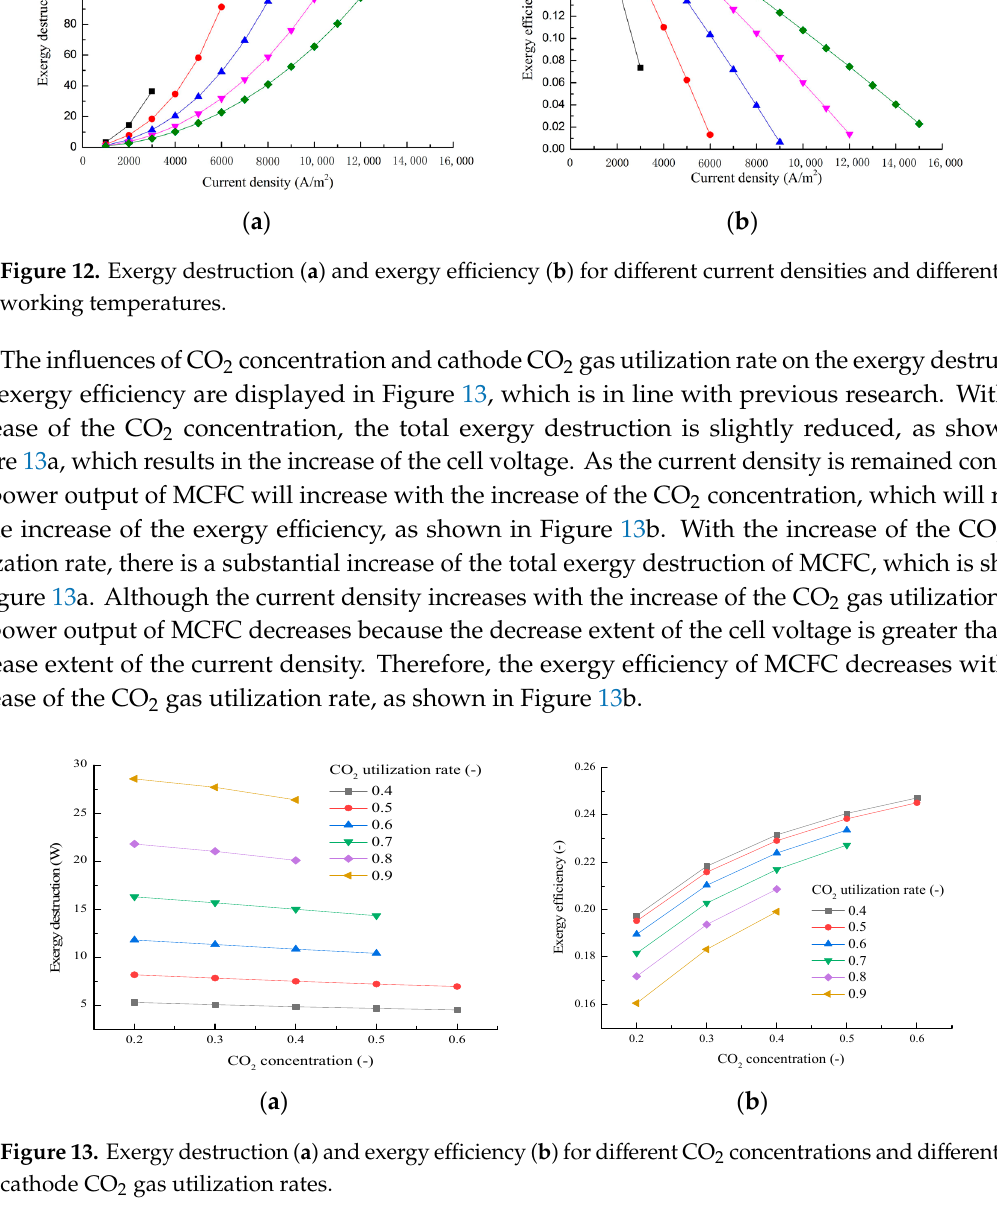
Figure 11. Experimental voltage and simulation voltage for different concentrations of CO 2 .